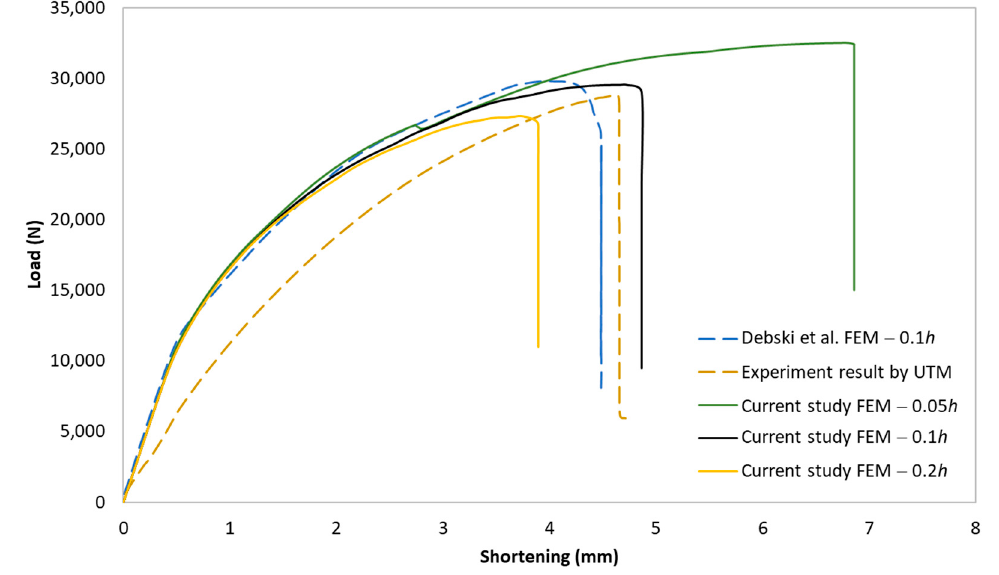
Figure 9. Post-buckling equilibrium paths of the GFRP strut. FEM: finite element model, UTM: universal testing machine.